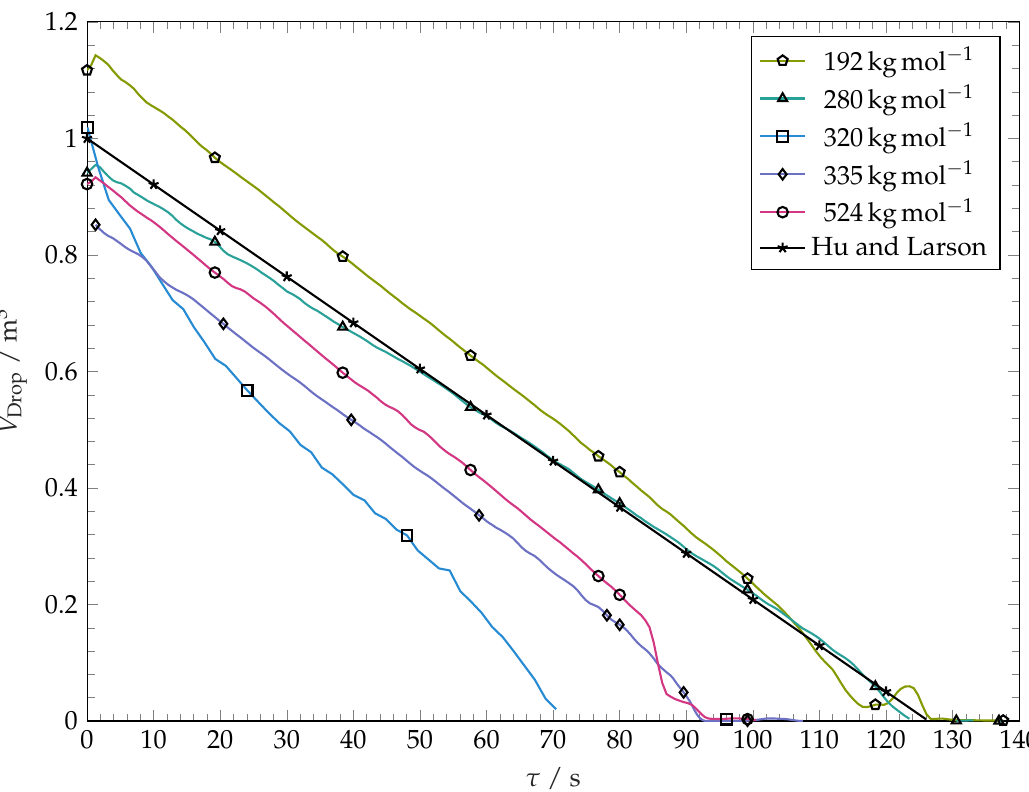
Figure 7. Solvent droplet volume over time during spreading and evaporation as obtained by image evaluation. The black line represents the results of computations according to the model presented in Hu and Larson [39]. Plot markers are placed for easier distinction between